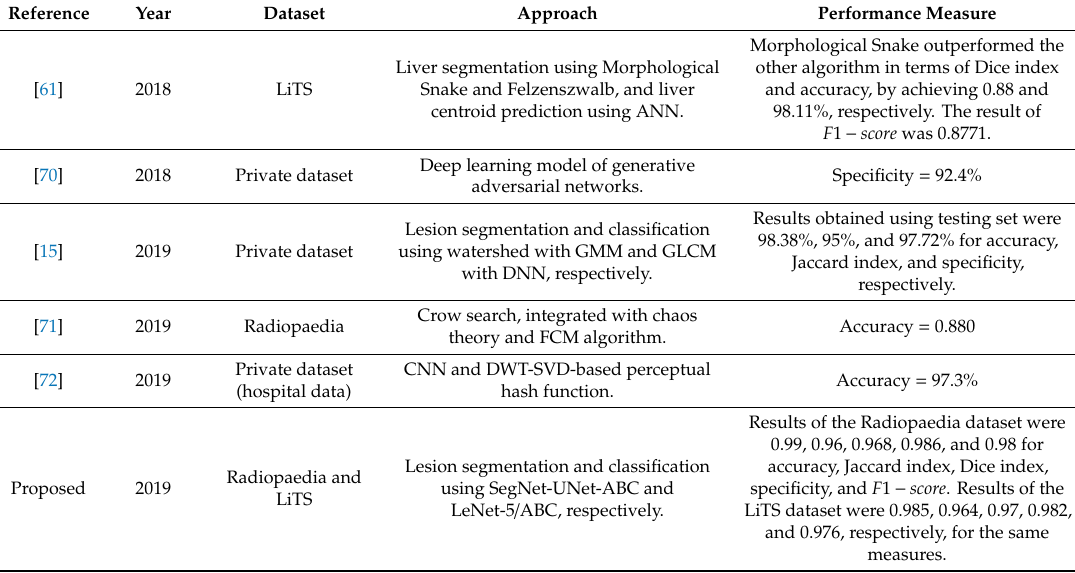
Table 8. Comparison to other works on liver cancer diagnosis using CT